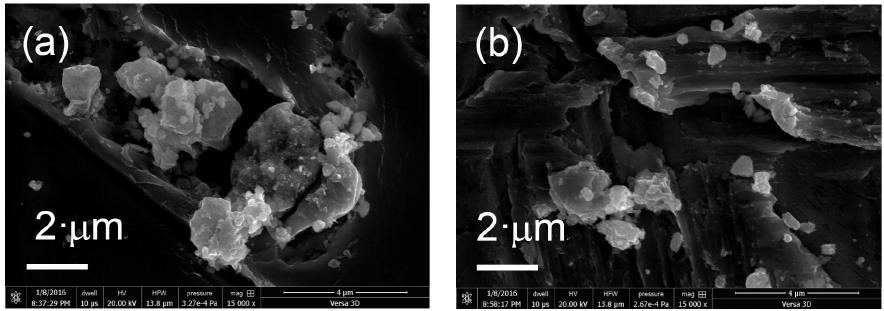
Figure 4. Cont. Figure 4. Cont.